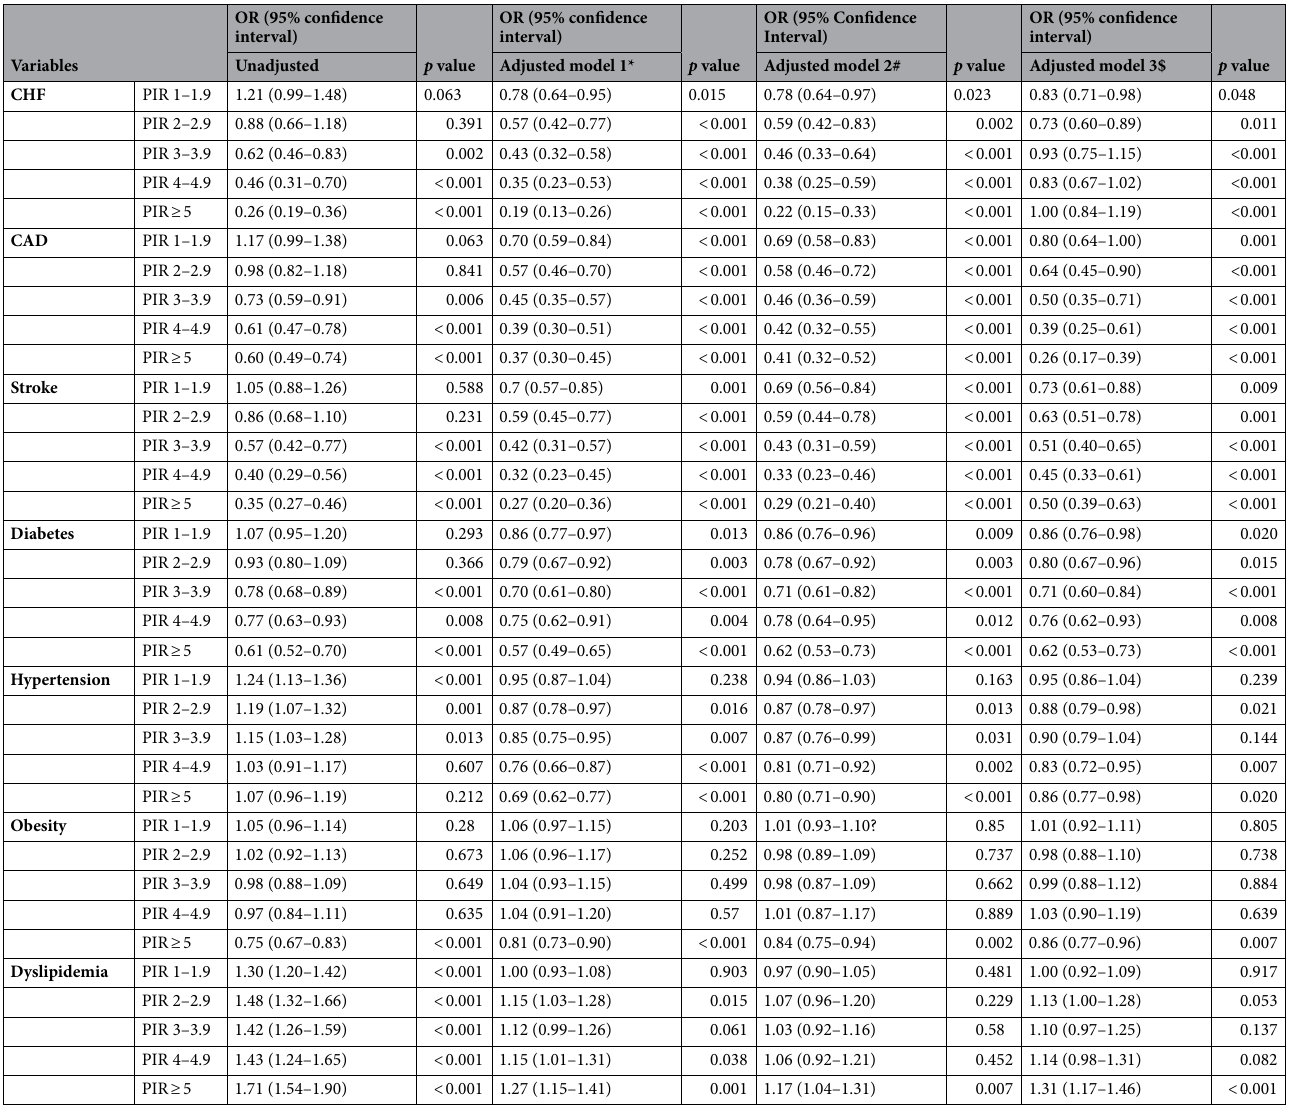
Table 3. Odds ratios (95% confidence intervals) for the prevalence of cardiovascular comorbidities stratified by PIR (Reference category PIR < 1). * Models are adjusted for age, sex and race/ethnicity. # Models are adjusted for age, sex, race/ethnicity, citizen status, marital status, education status and insurance (yes or no, not the types). $ Models are adjusted for age, sex, race/ethnicity, citizen status, marital status, education status and insurance (yes or no, not the types), diabetes mellitus, hypertension, smoker, obesity, dyslipidemia. In model $, we excluded the outcomes of particular analysis for diabetes mellitus, hypertension, obesity and dyslipidemia as covariate in the model. Key: PIR: Family poverty to income ratio, CAD: Coronary artery disease, CHF: Congestive heart